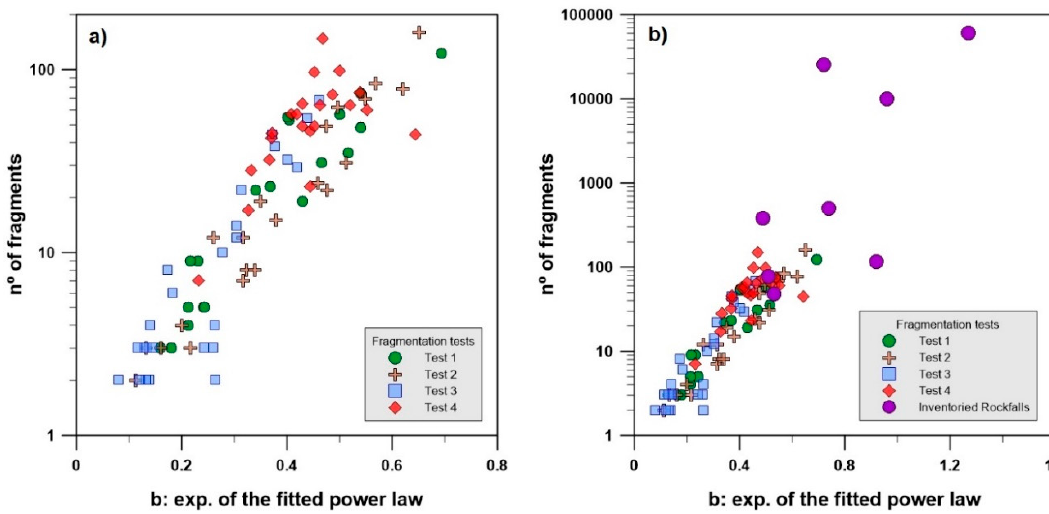
Figure 16. Number of fragments and the exponent of the fitted power laws of the BSD obtained from: ( a ) the real-scale fragmentation tests; ( b ) adding the data of natural fragmental rockfall inventory [6]. Each block size distribution has two important descriptors, the biggest fragment, that controls the bottom right position of the BSD, and the total number of fragments, that controls the slope of the distribution (intensity of the fragmentation).